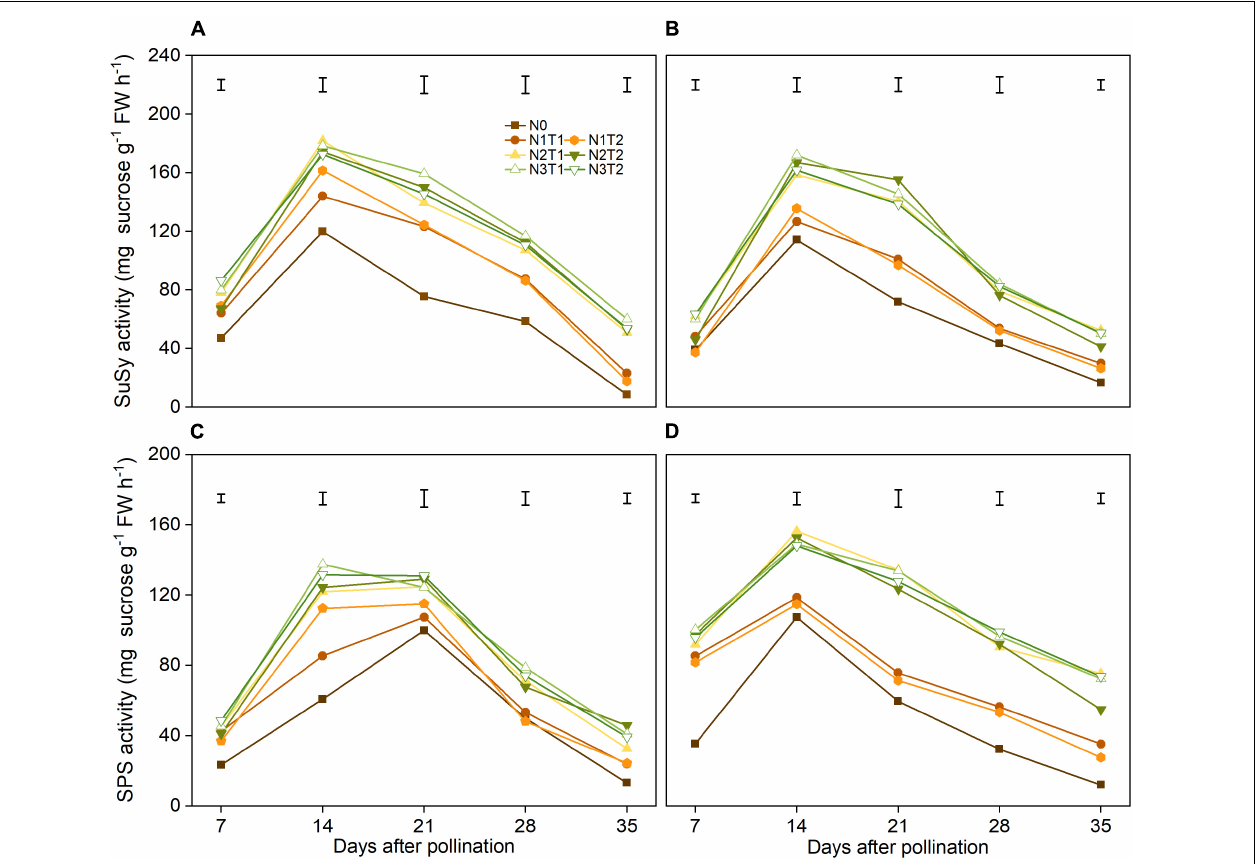
FIGURE 4 | Effects of N rate and time on the activities of SuSy and SPS in 2019 (A,C) and 2020 (B,D) . SuSy, sucrose synthase; SPS, sucrose phosphate synthase. The vertical bars represent the LSD ( n =